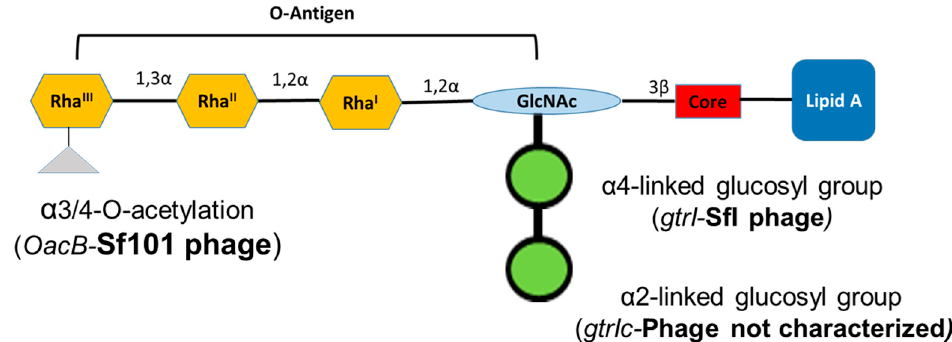
Figure 1. Schematic representation of the lipopolysaccharide of Shigella flexneri serotype 1c. Each tetrasaccharide unit of O-antigen has one N -acetylglucosamine (GlcNAc) and three rhamnose sugars (Rha). All serotype 1c strains have two glucosyl groups attached to GlcNAc and some of them have an additional acetyl group attached to Rha III .